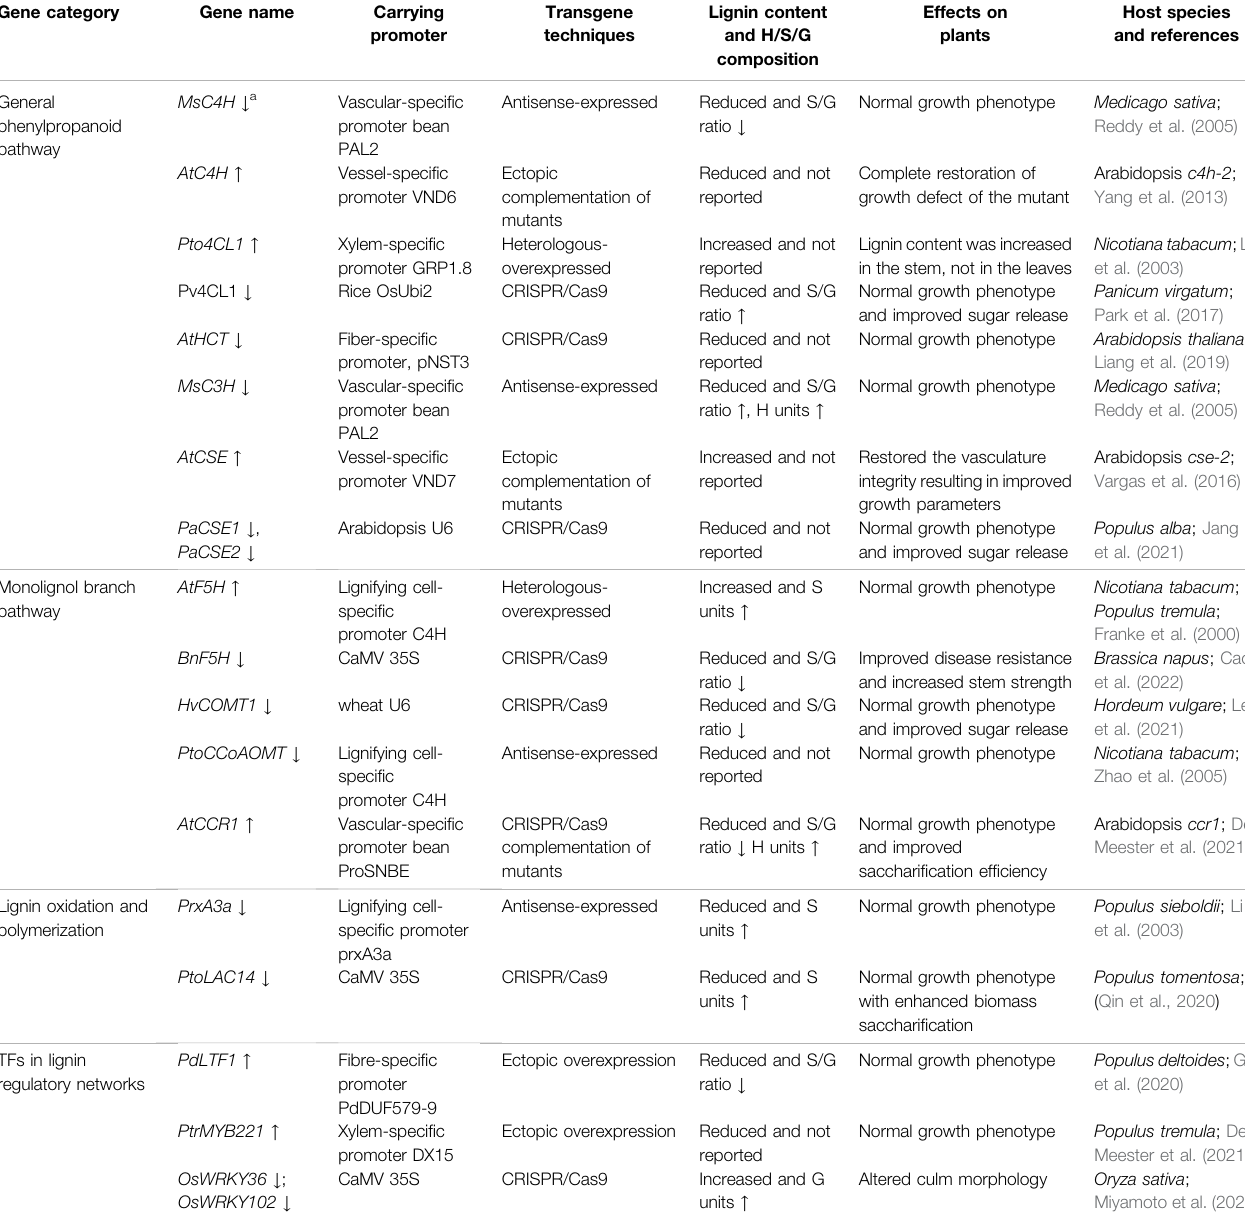
TABLE 3 | Targeted genetic modi fi cation of lignin biosynthesis in plants using speci fi c promoters and/or sophisticated genome editing